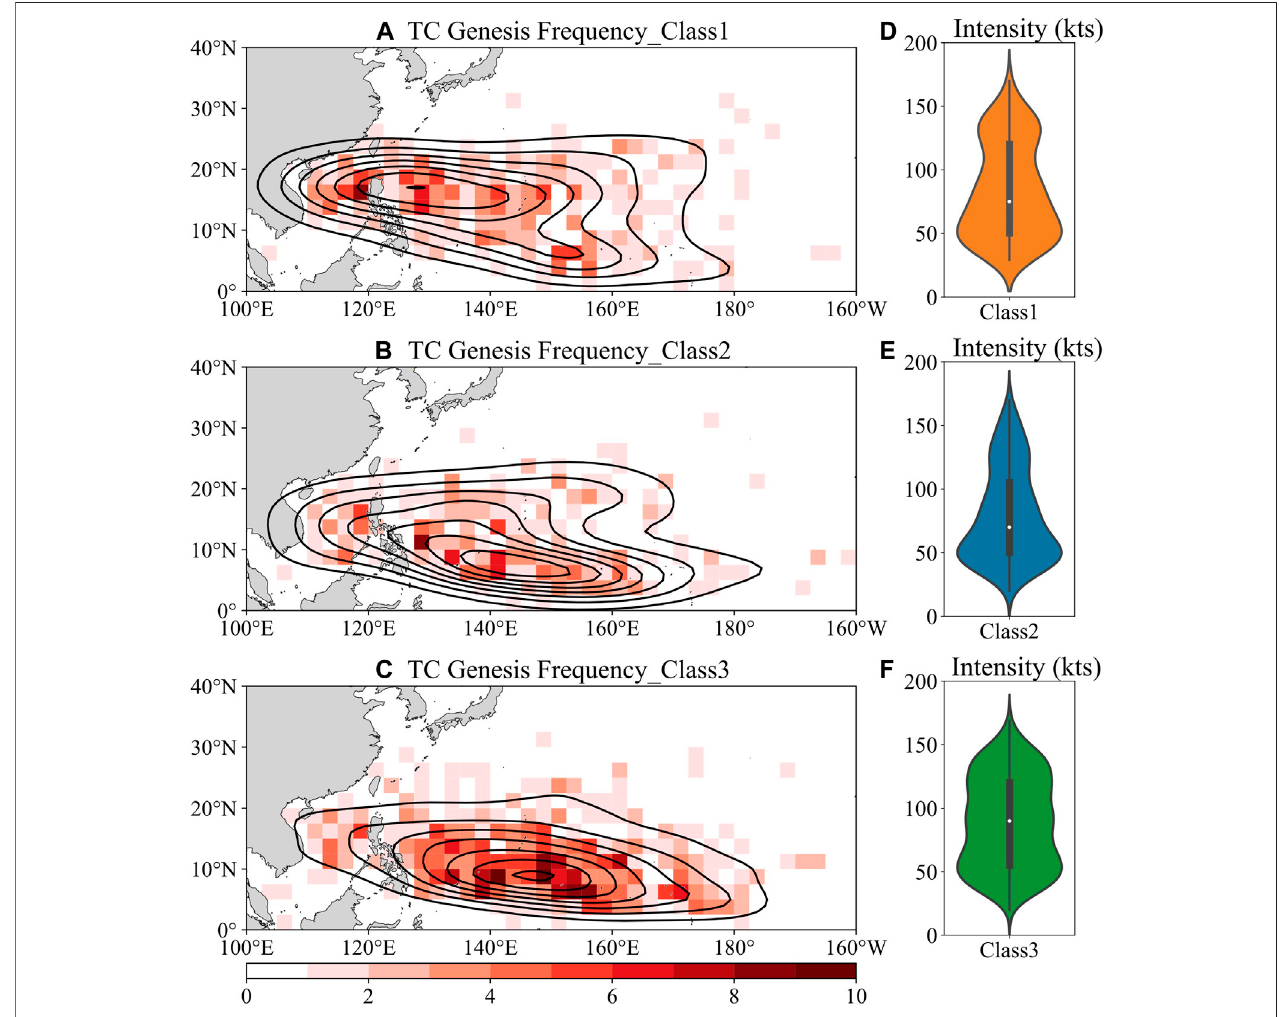
FIGURE4 |(A – C) are TCgenesisfrequency ofthe three classes, the contours are the KDE ofgenesis location, and the colour isthe genesis frequencyin one grid; (D – F) are the distribution of the intensity of each class. The colour and curve indicate the kernel density distribution for a given intensity. The thick inner line is the interquartile range, and the thin line is 95% of all cases. The white circle is the average of the intensity of each class.